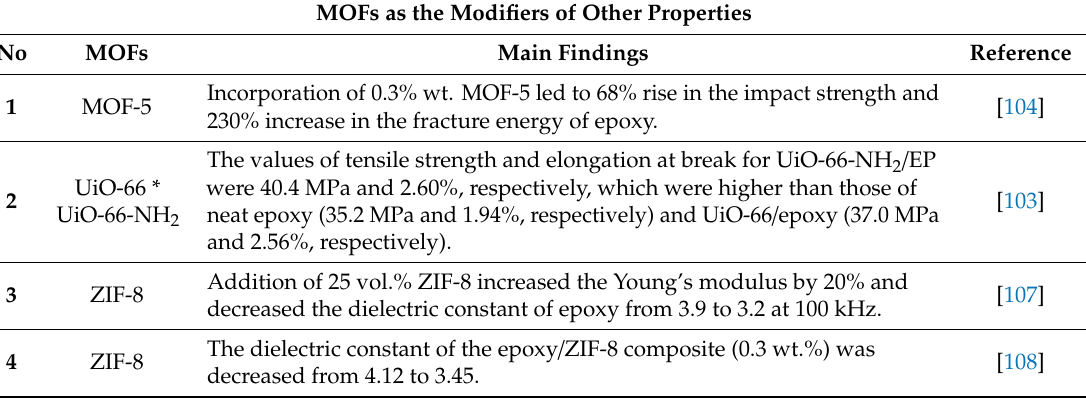
Table 3. Epoxy / MOF nanocomposites applied as coatings with satisfying mechanical and dielectric properties. The main outcomes of recent research are also